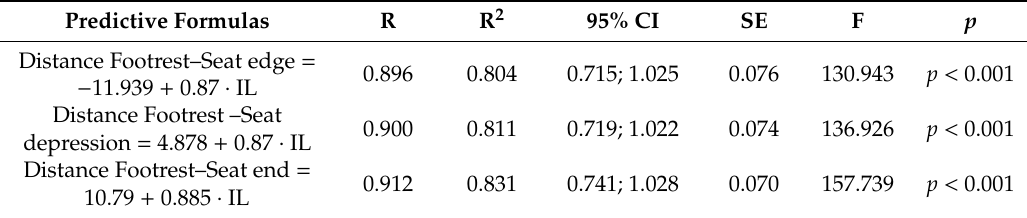
Table 4. Predictive formulas of the distance between the di ff erent internal equipment of the kayak. Predictive Formulas R R